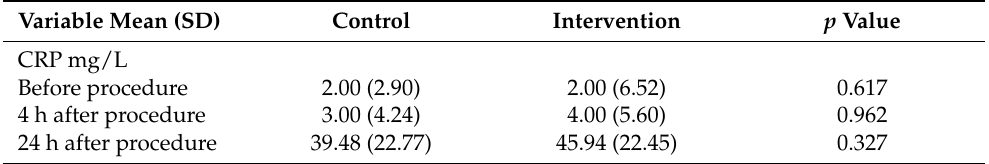
Table 5. C-Reactive Protein t test Results. SD = Standard